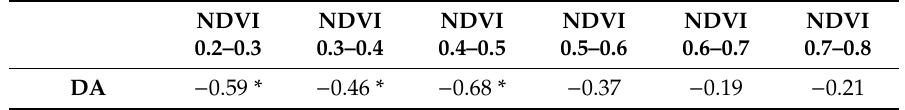
Table 3. The correlation between DA with spatial coverage of different NDVI categories in Afghanistan between 2001 and 2018.